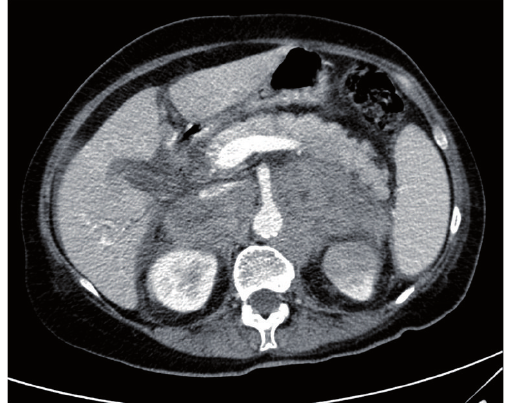
Figure 2: H&E stain and immunostaining for CD20 ( × 400) showing large dysplastic CD20 positive